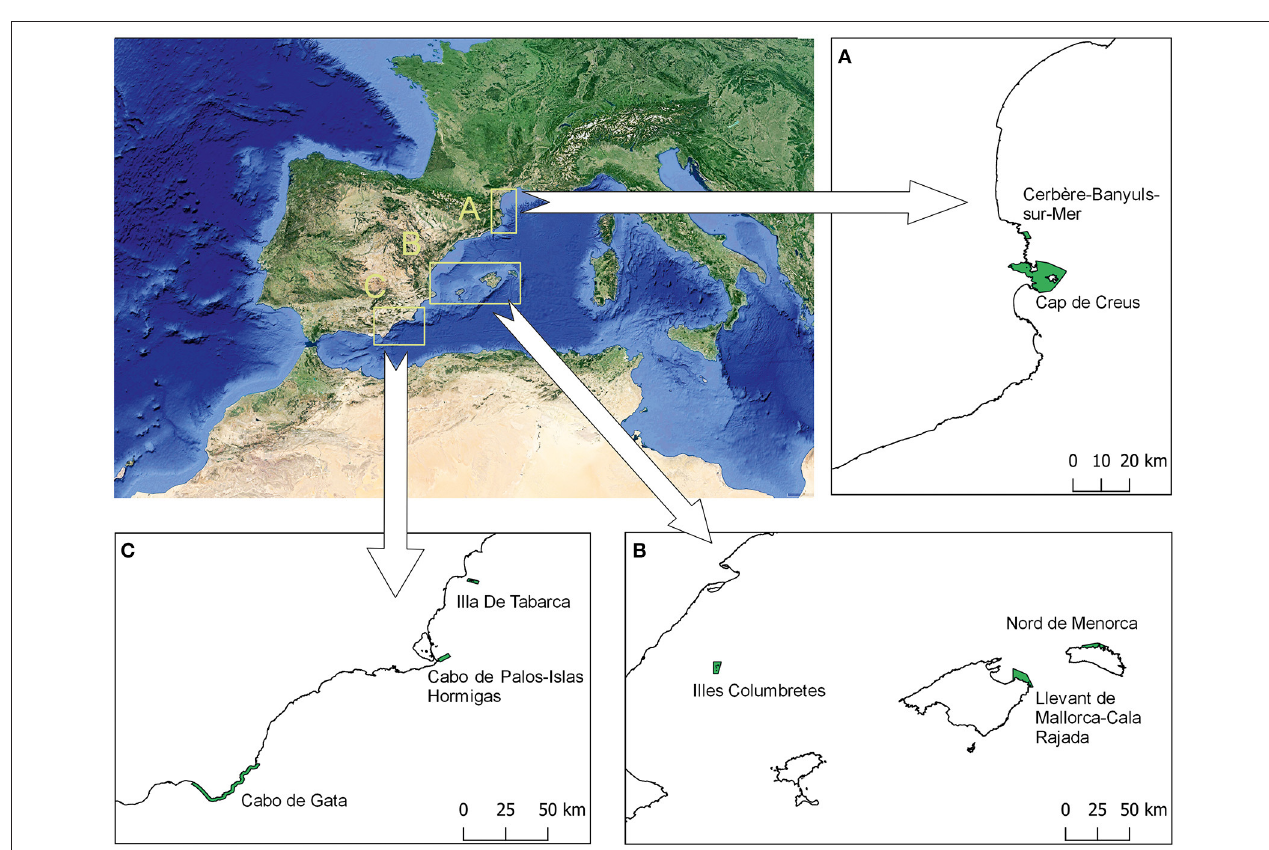
FIGURE 3 | Location of the eight western Mediterranean marine protected areas, all of them RESERVEBENEFIT project case studies, that have contributed to the results of this study.